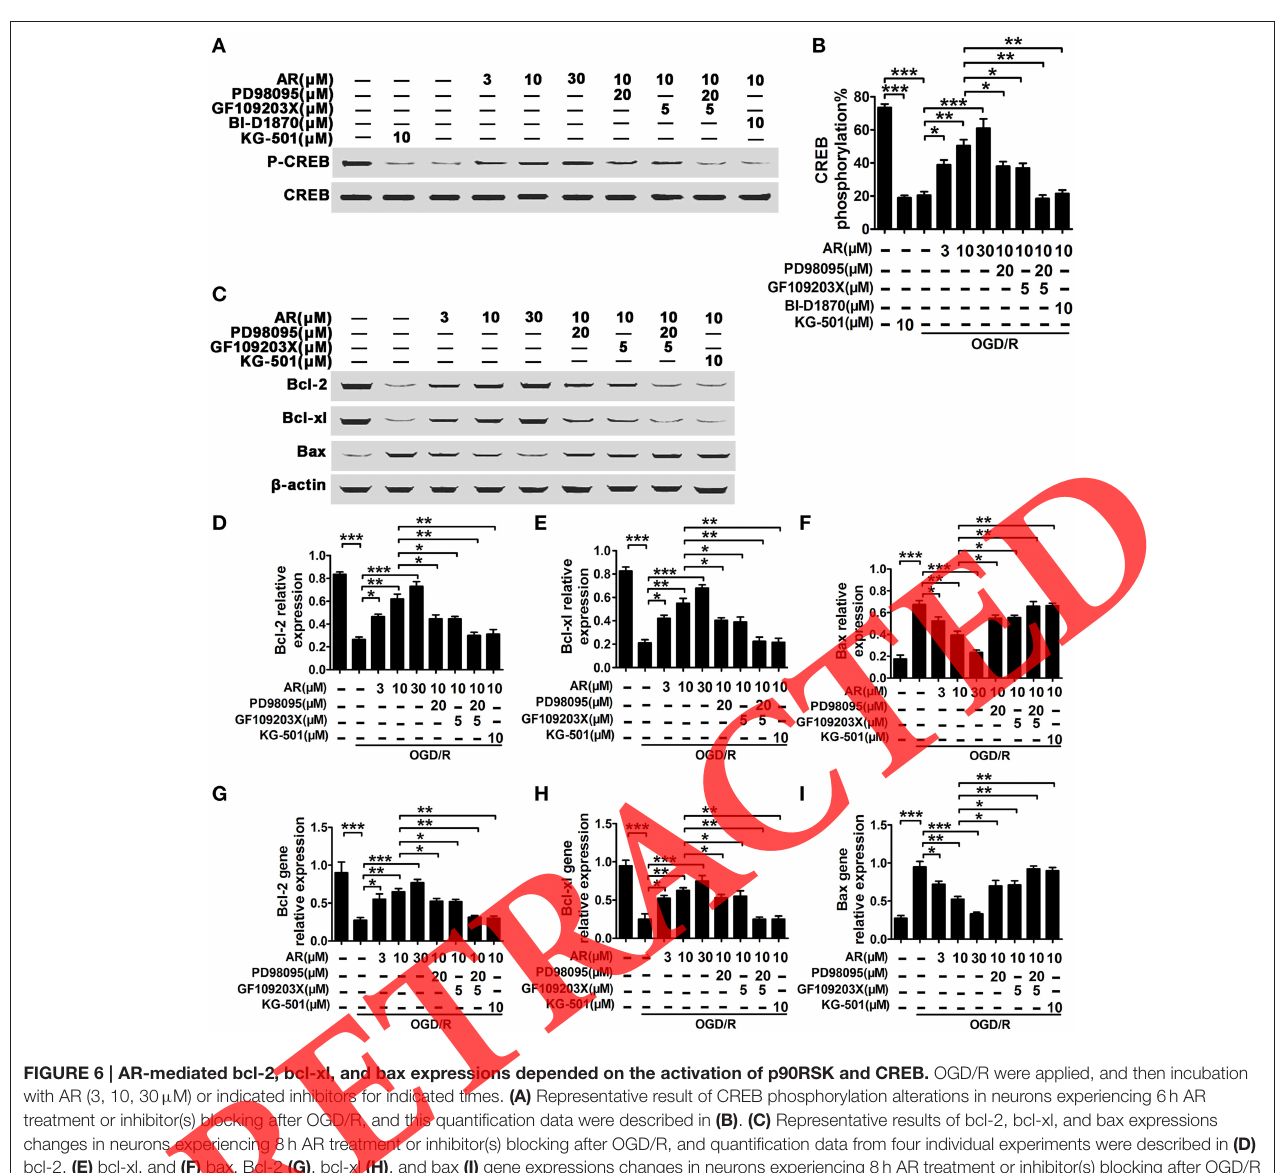
FIGURE 6 | AR-mediated bcl-2, bcl-xl, and bax expressions depended on the activation of p90RSK and CREB. OGD/R were applied, and then incubation with AR (3, 10, 30 µ M) or indicated inhibitors for indicated times. (A) Representative result of CREB phosphorylation alterations in neurons experiencing 6h AR treatment or inhibitor(s) blocking after OGD/R, and this quantification data were described in (B) . (C) Representative results of bcl-2, bcl-xl, and bax expressions changes in neurons experiencing 8h AR treatment or inhibitor(s) blocking after OGD/R, and quantification data from four individual experiments were described in (D) bcl-2, (E) bcl-xl, and (F) bax. Bcl-2 (G) , bcl-xl (H) , and bax (I) gene expressions changes in neurons experiencing 8h AR treatment or inhibitor(s) blocking after OGD/R were evaluated using qRT-PCR assay, and quantification data were from four individual experiments. Results mentioned-above were mean ± SD for four individual experiments which, for each condition, were performed in quadruplicate. * P < 0.05 ; ** P < 0.01 ; *** P < 0.001